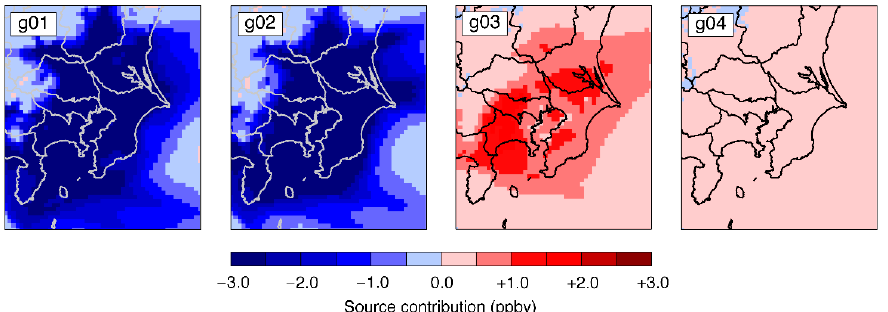
Figure 10. Source contributions of O 3 from four domestic sources of g01, g02, g03, and g04, calculated by chemistry updates B, averaged during P1.